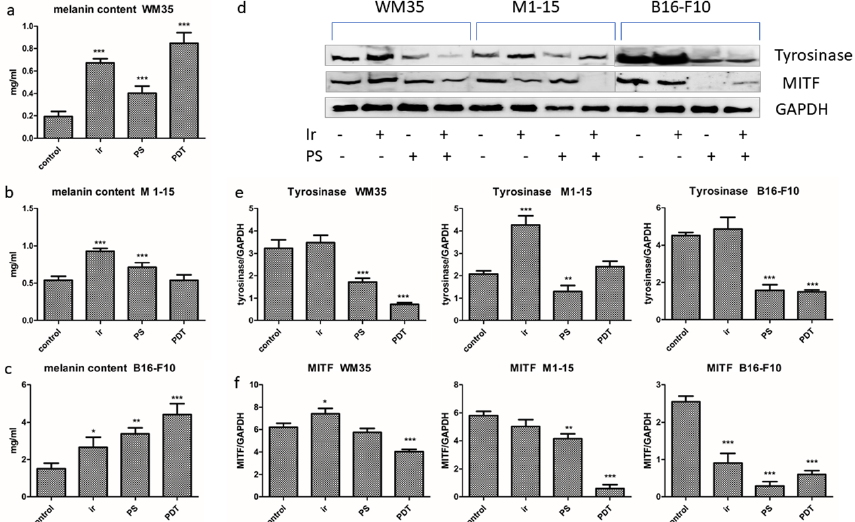
Figure 5. Melanogenesis. Total melanin content ( a ) WM35, ( b ) M1-15, and ( c ) B16-F10 ( d ) Expression of tyrosinase and MITF, 1 = control, 2 = irradiated (100 mJ/cm 2 ), 3 = THPP (15 µg/mL), 4 = PDT (THPP 15 µg/mL and irradiation 100 mJ/cm 2 ). Graphical representation of quantitative WB results: tyrosinase ( e ), MITF ( f ). Each bar represents mean ± SD ( n = 3). * = p < 5.0 × 10 − 2 , ** = p < 1.0 × 10 − 2 , *** = p < 1.0 × 10 − 3 compared to control.